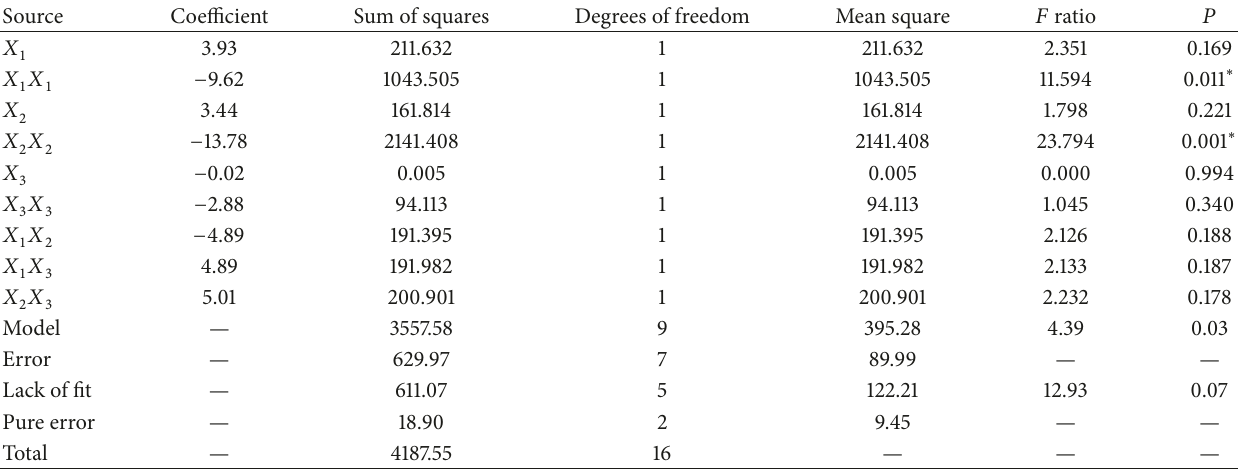
Table 3: ANOVA with estimated regression coefficients for D( − ) lactic acid